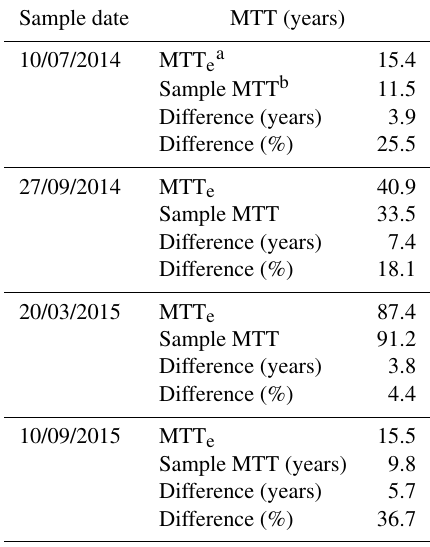
Table 4. Estimates of the difference between calculated mean transit times (MTTs) and that estimated from the mixing of waters from different tributaries at Love Creek